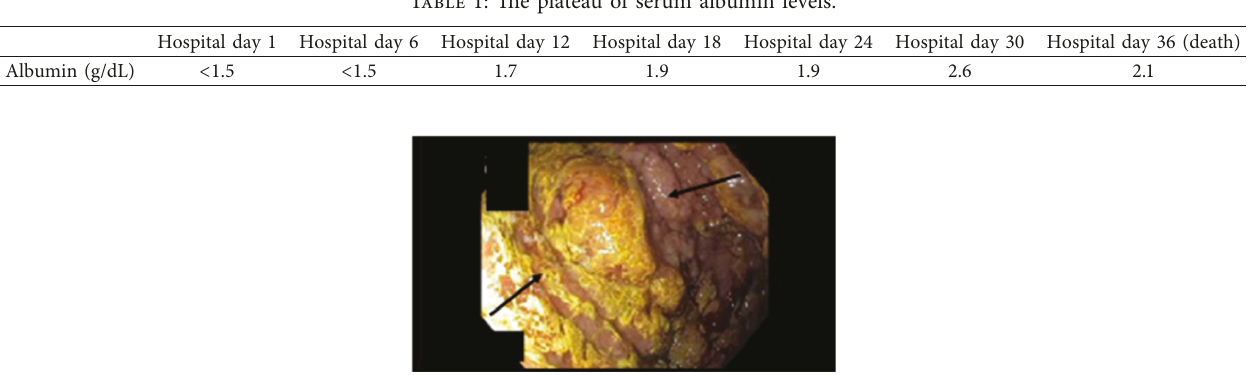
Figure 1: Esophagogastroduodenoscopy of the gastric mucosa reveals a suspected mass in the gastric mucosa, as highlighted by arrows, along with areas of inflammation. Imaging is limited by bile reflux. Image Credit: Michael Sciarra.